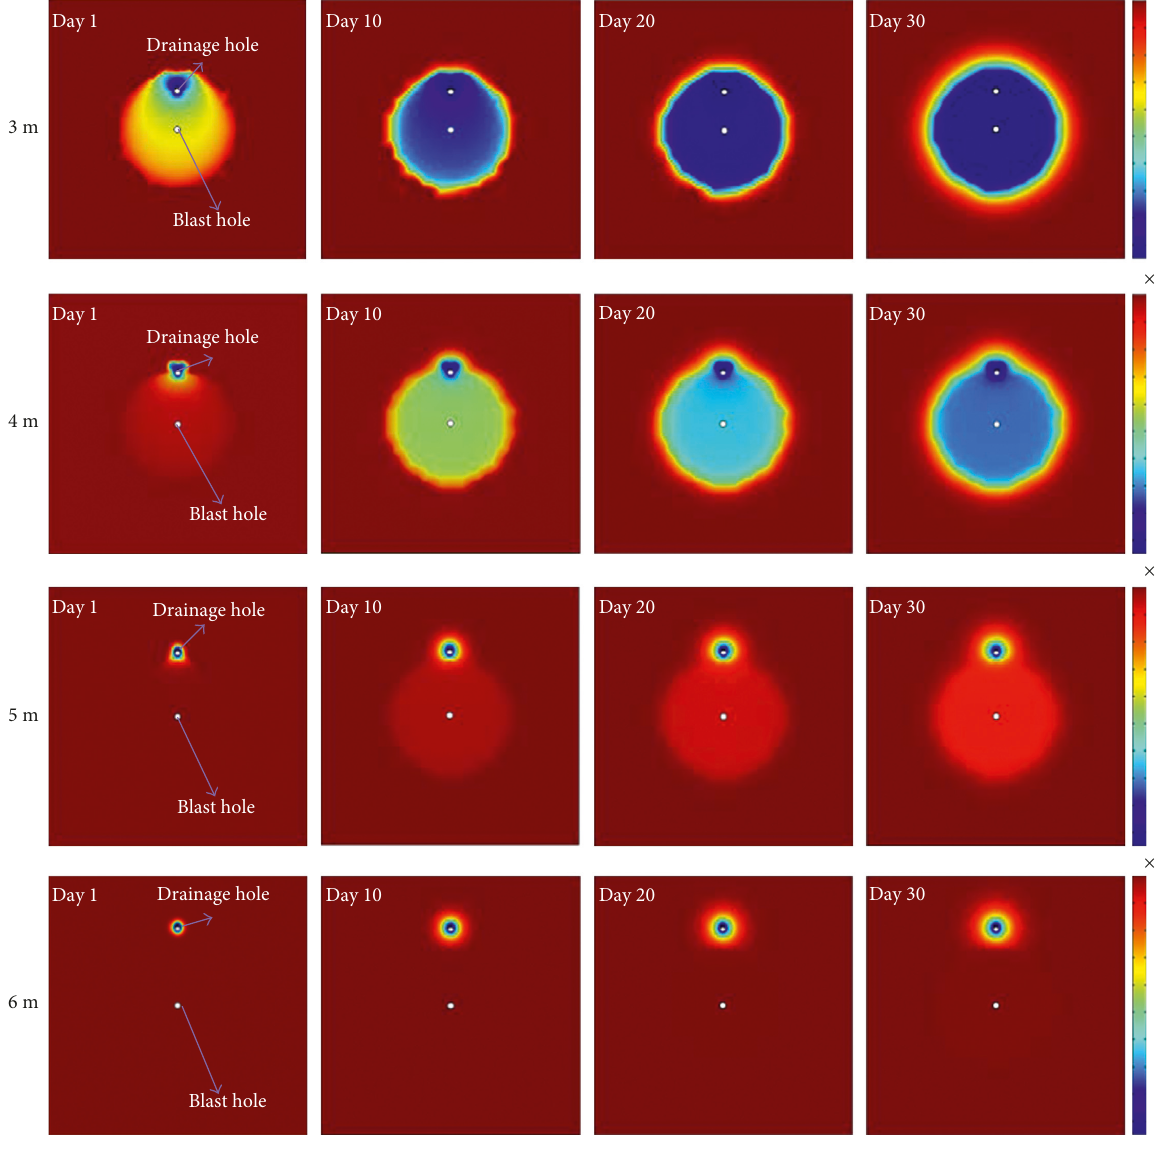
Figure 13: Gas drainage effects after